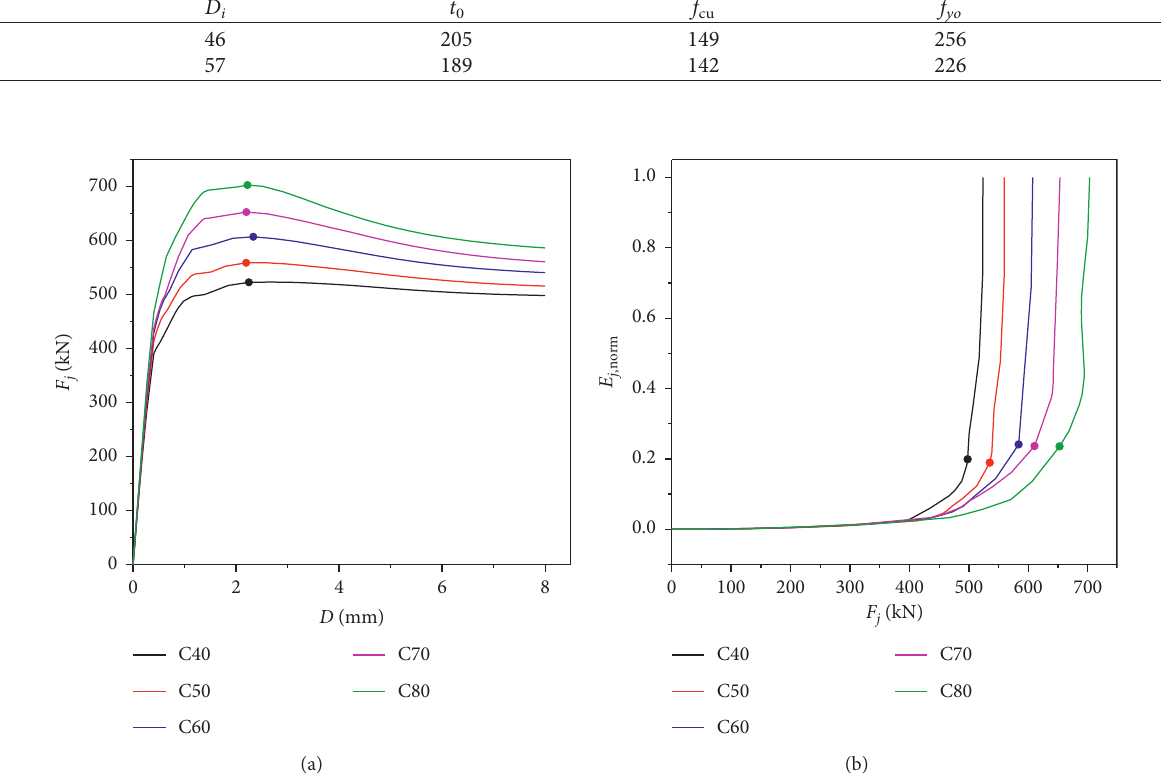
Figure 10: (a) F − D curves of different concrete strength. (b) E j